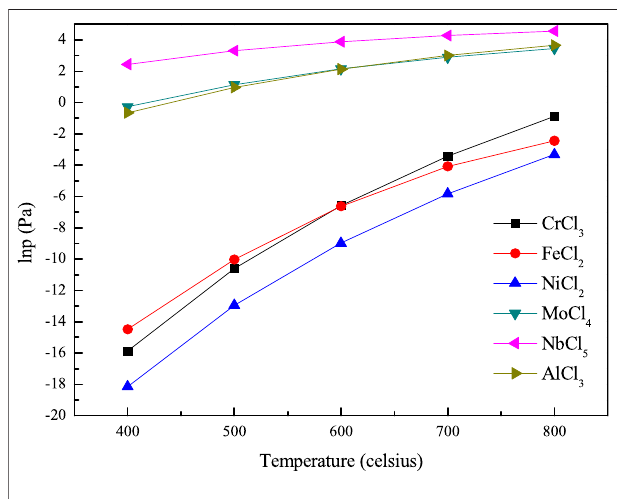
FIGURE 11 | Equilibrium vapor pressures of solid chlorides at 400 – 800 ° C calculated by HSC6.0.